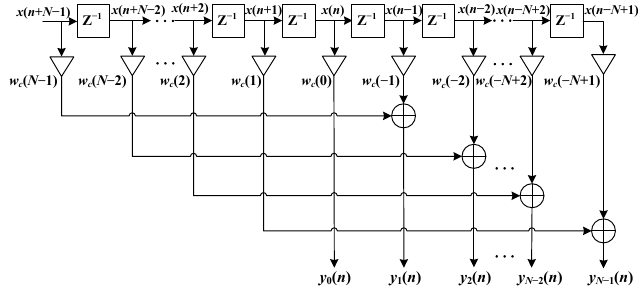
Figure 1. Data preprocessing diagram of apDFT.